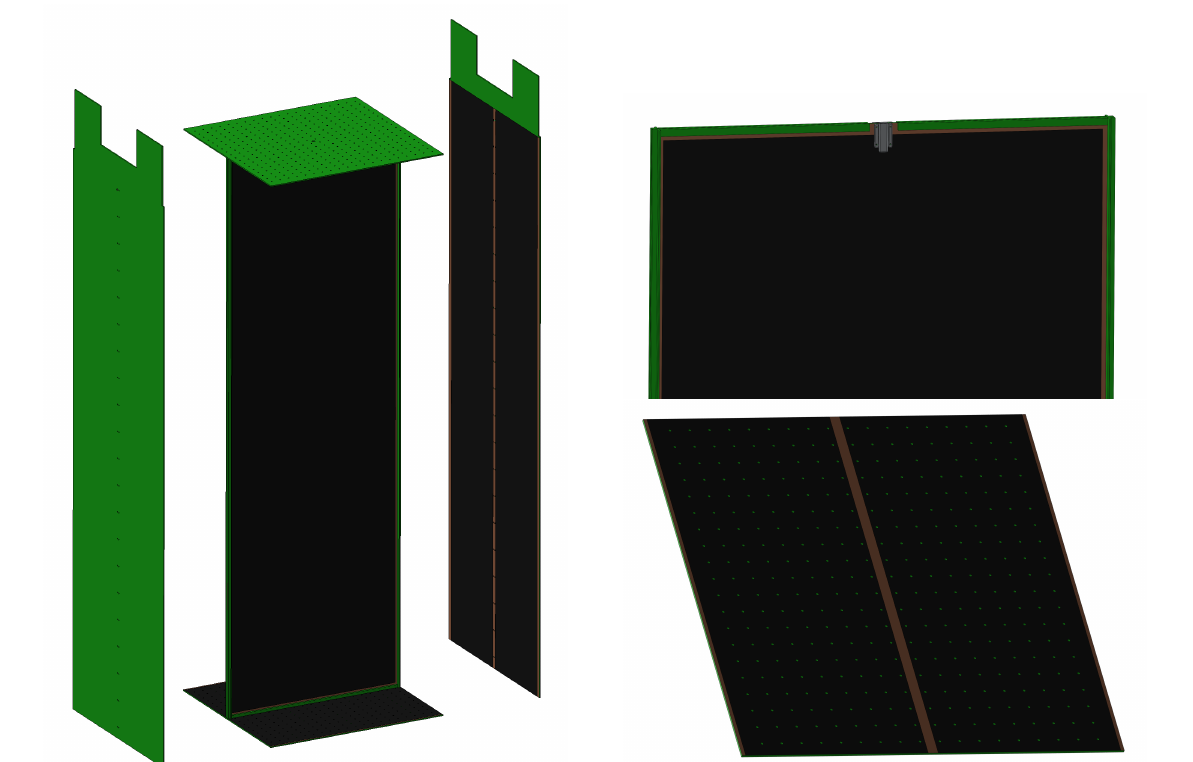
Figure 6. ( Left ) Exploded-view drawing of the field-shaping structure of a TPC module. ( Top right ) High-voltage socket at the top of the cathode. ( Bottom right ) Bottom field-shell